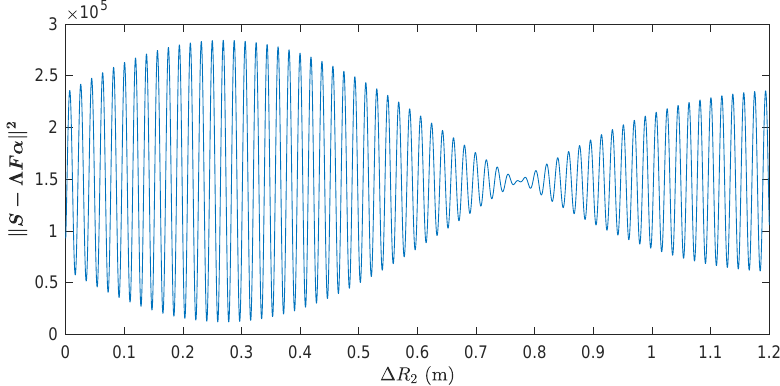
Figure 6. Illustration of the nonconvexity of the l 1 -norm regularised optimisation problem (31). The objective function of (31) is plotted against ∆ R 2 assuming that α is perfectly known.